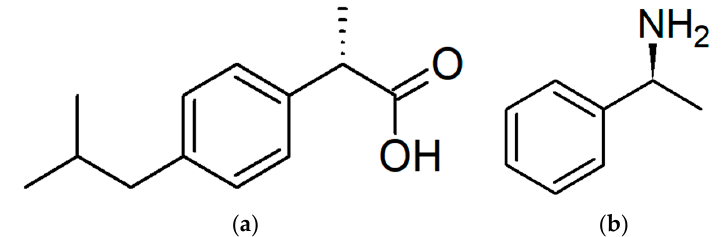
Figure 1. Structural formula of ( a ) S-IBU and ( b ) S- α MBA.